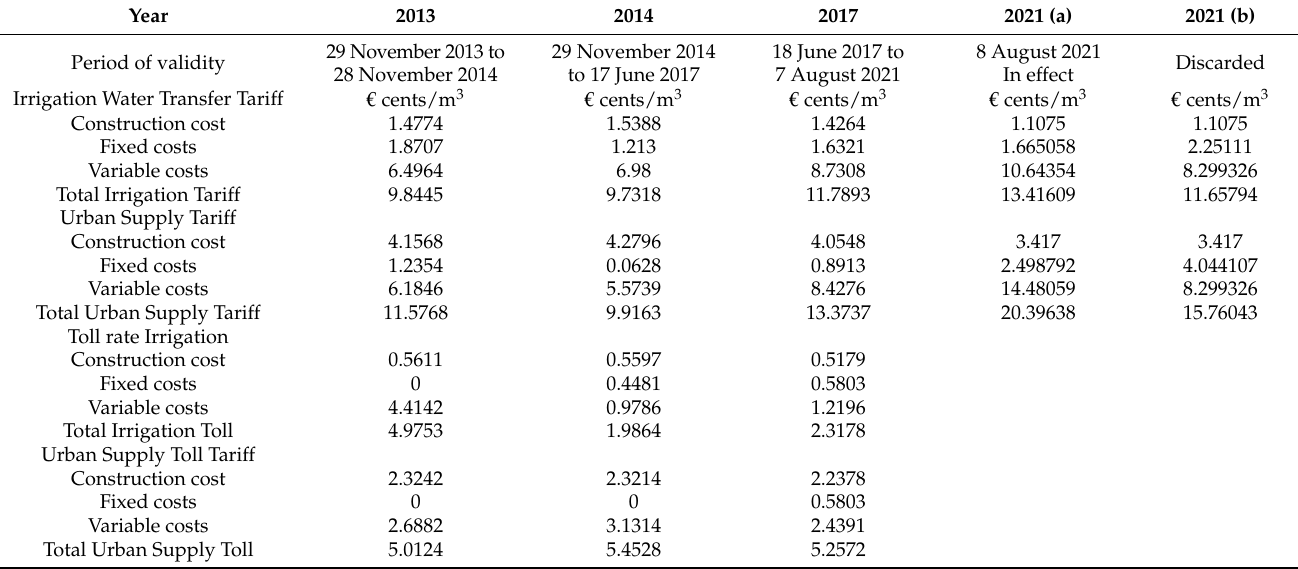
Table 2. Tariffs for the Tagus-Segura water transfer in 2013, 2014, 2017 and the alternatives for 2021. Source: [43] and own elaboration based on information from